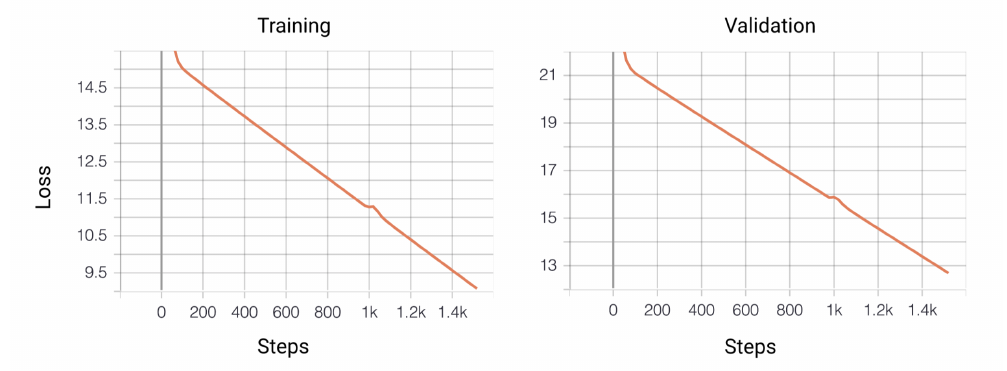
Figure 4. Tile2Vec model training and validation loss